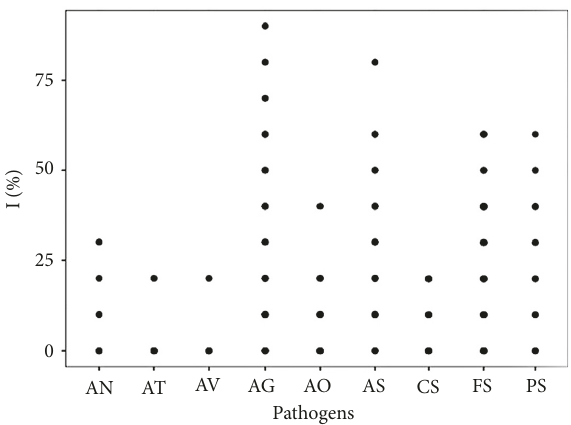
Figure 7: FI in seeds. I (%) � incidence percentage, AN � A. niger , AT � A. terreus , AV � A. versicolor , AG � A. glaucus , AO � A . ochraceus , AS � Alternaria sp., CS � Cladosporium sp., FS � Fusarium sp., and PS � Penicillium